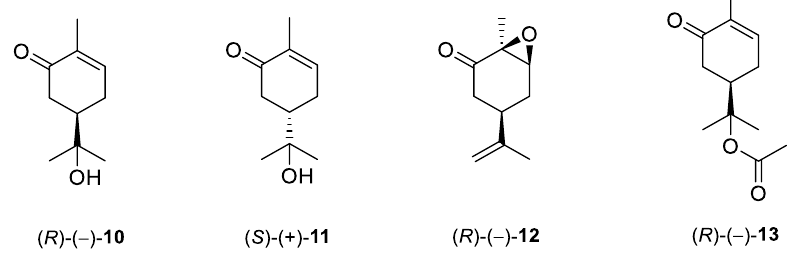
Figure 5. Carvone derivatives examined against tumor cell lines: HCT-116 (colon), OVCAR-8 (ovarian) and SF-295 (brain).